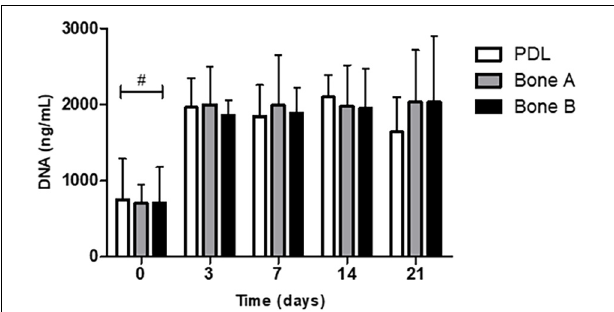
FIGURE 3 | DNA concentration of PDL cells and alveolar bone cells bone A and B at day 0, 3, 7, 14, and 21. Means ± SD are shown ( n = 5). No significant differences were found between the 3 cell cultures at all time points. # p < 0.05 between day 0 and the other time points for PDL, bone A, bone B (Friedman test with Dunn’s multiple comparison post hoc test).